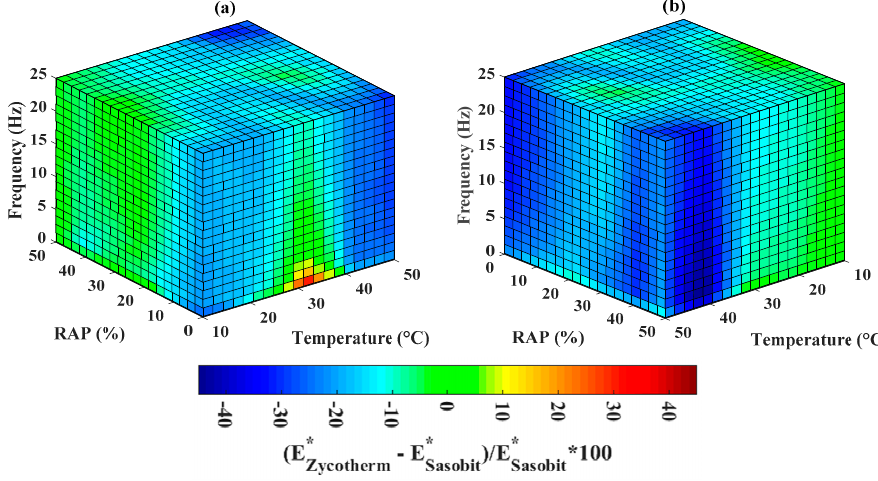
Figure 9. Box map comparison analysis for the two technologies in varying %RAP, frequencies and temperatures, ( a ) standard view; and ( b ) opposite view.